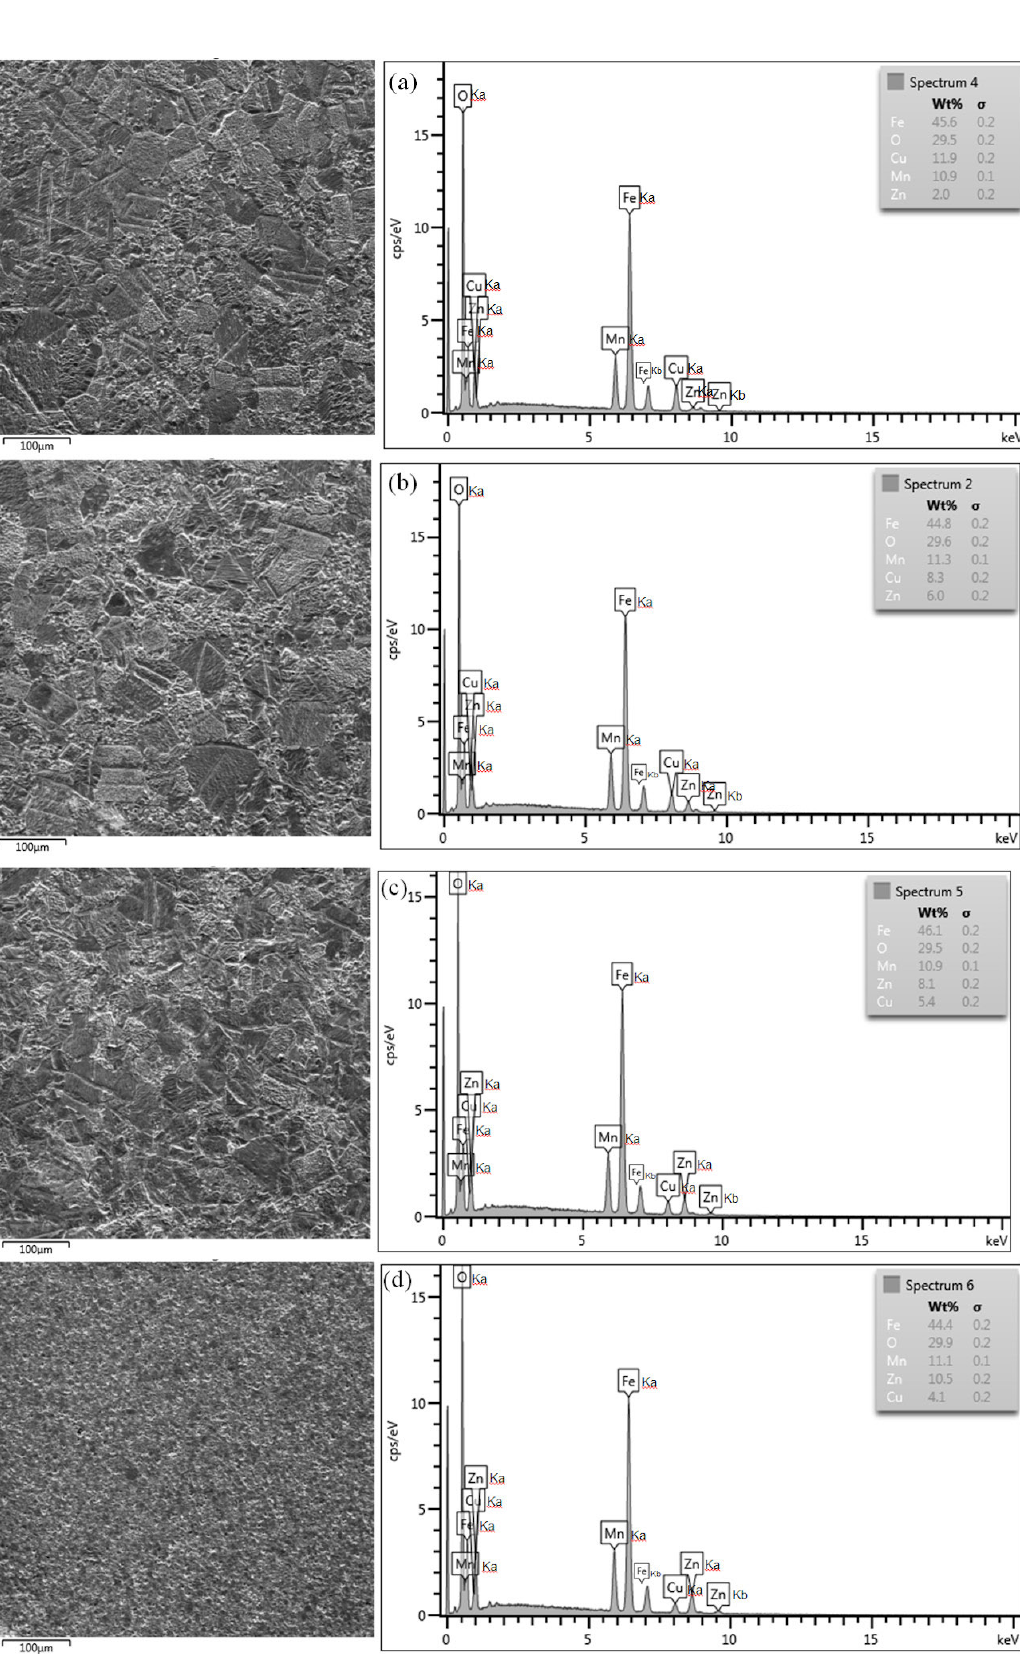
Figure 5. Energy Dispersive Spectroscopy (EDS) analysis for the pellet sample with β = 0.10 (a), 0.20 (b), 0.30 (c) and 0.40